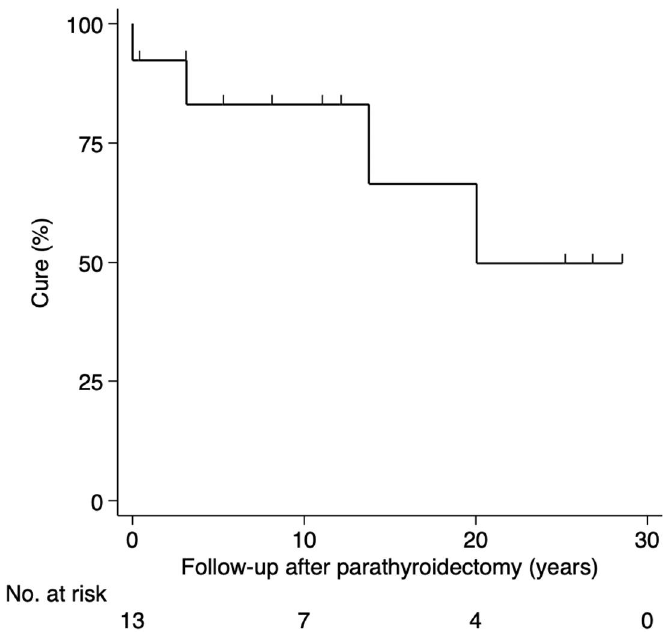
Figure 3. Status after surgery for PHPT in the Danish MEN 2A cohort 1930–2021. Abbreviations: PHPT, primary hyperparathyroidism; MEN 2A, multiple endocrine neoplasia type